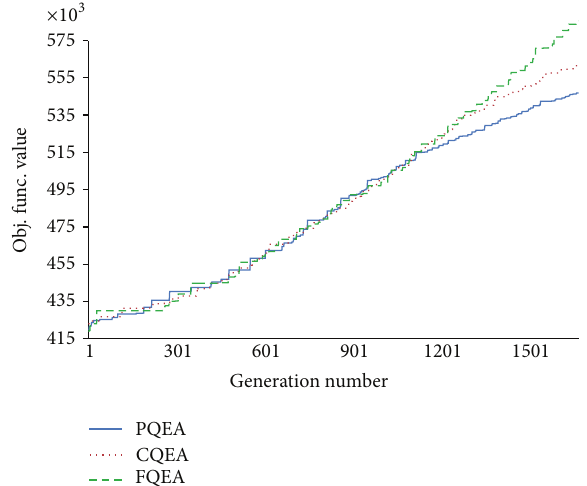
Figure 38: Convergence graph of PQEA, CQEA, and FQEA on 0- 1 knapsack problem circle data instances with number of items, 𝑀 , being 5000 and capacity, 𝐶 , being 5% of total